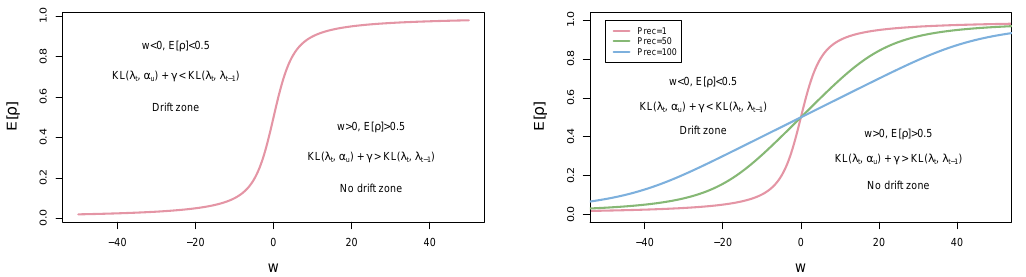
Figure 3. The relationship between ω t and E q [ ρ t ] according to Equation (28) ( left ) and Equation (29) ( right ): see Section 5.3 for details.